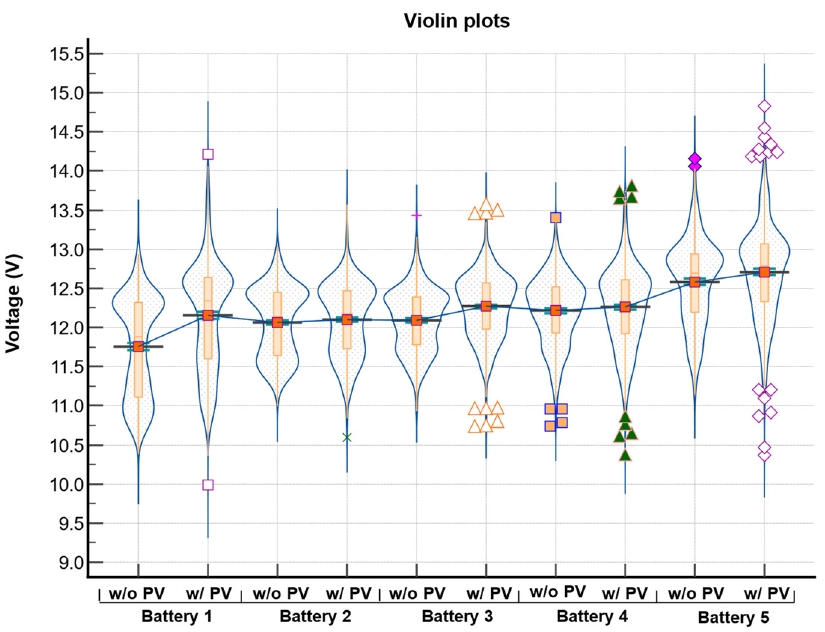
Figure 11. Data on each battery for runs with PV (w/) and without (w/o), (Symbols represent battery voltage outliers). Table 4. Statistical data for each ba tt ery with PV (w/) and without (w/o). Data Comparison